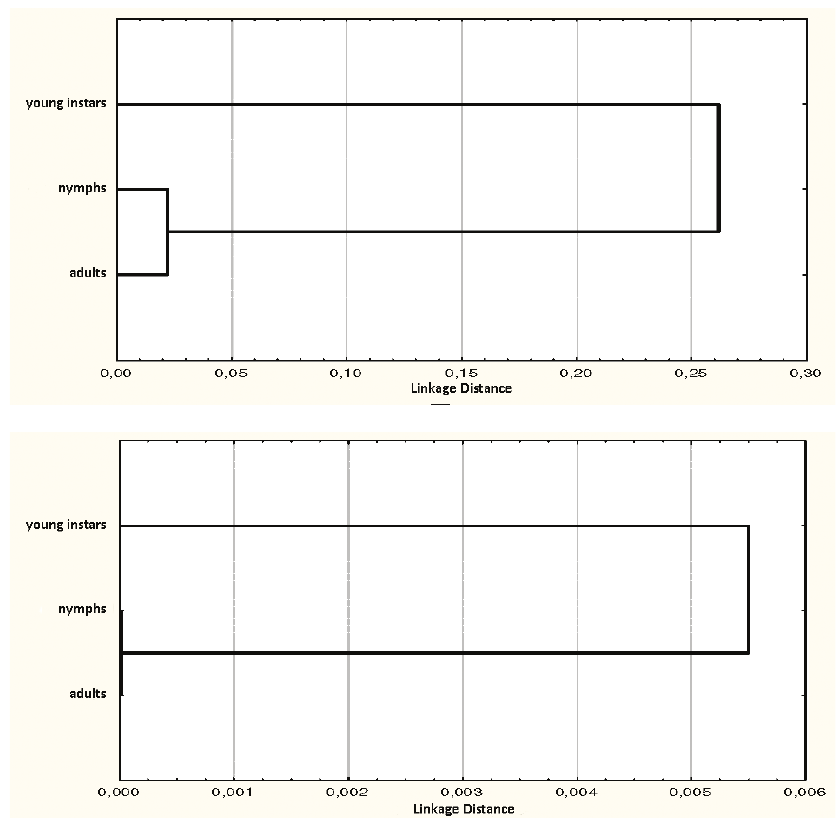
Figure 4. Overlap analysis of food resource exploitation conducted in individuals of different age (young instars, nymphs and adults). The dendrograms were performed using euclidean distances based on the Morisita-Horn index matrices. (a: T. cavicola , b: T. andreinii ).